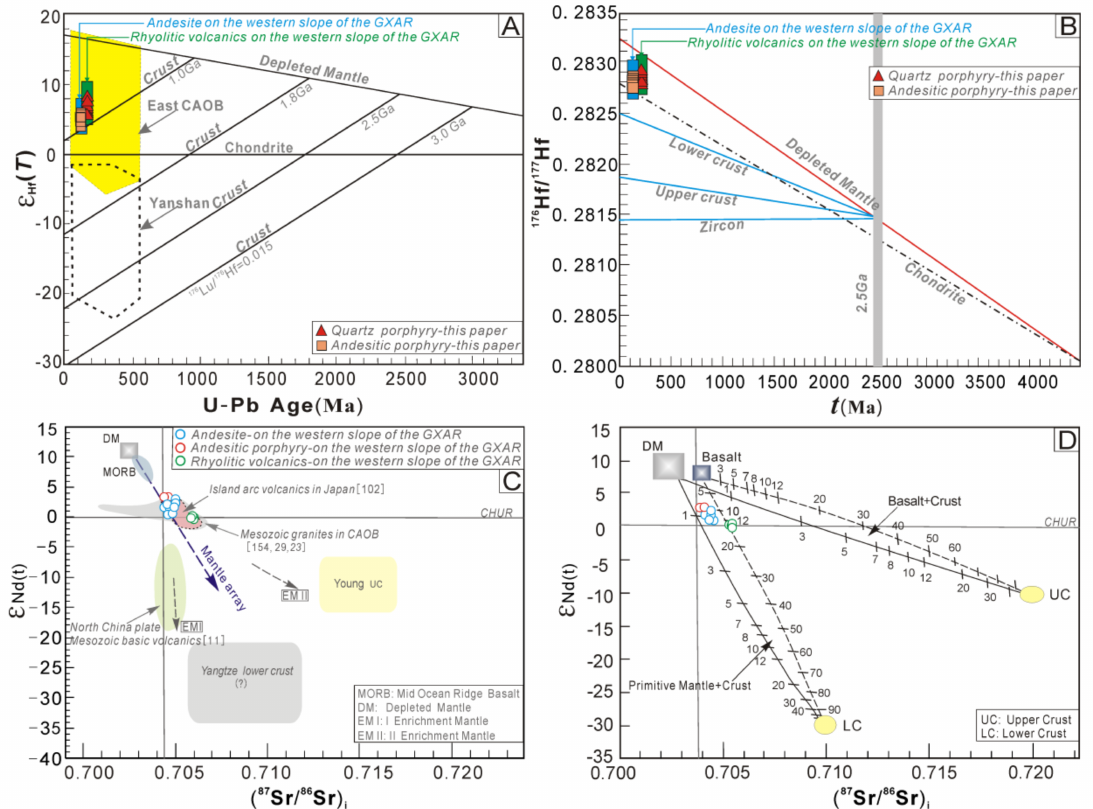
Figure 8. ε Hf(t) versus age plot of zircons ( A ) and 176 Hf / 177 Hf versus age plot of zircons ( B ) [81,82]. ( 87 Sr / 86 Sr) i – ε Nd(t) diagrams ( C ) and ( D ) of the andesite porphyry, andesite and rhyolitic volcanics